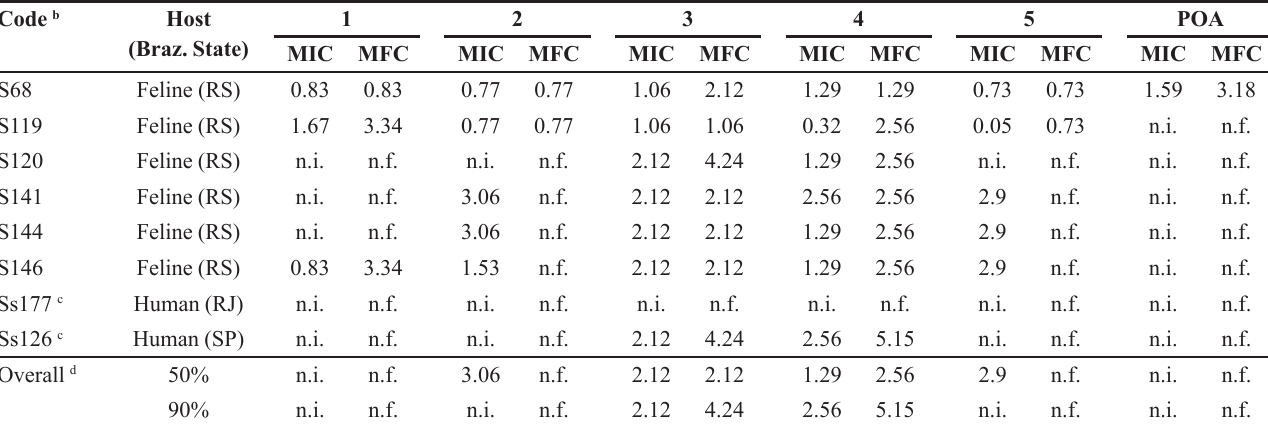
TABLE I - Minimal inhibitory concentration (MIC) and minimal fungicidal concentration (MFC) of different pyrazinoic acids (POA) molecules (mg/mL) to Sporothrix brasiliensis isolated from cats in Southern Brazil a